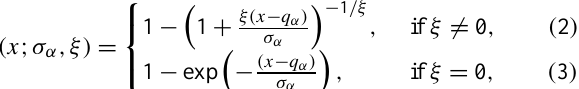
a mean cluster size of about 1 . 25 days). The central rainfall values can therefore be considered to be close to the case of complete